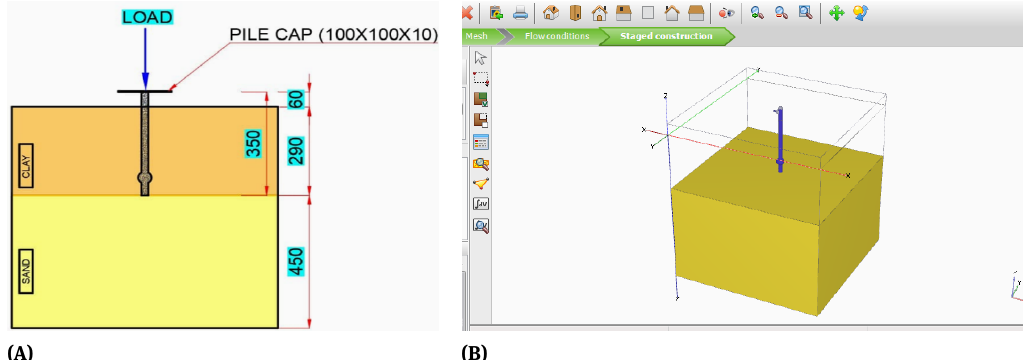
Figure 2: 3-Dimensional model of single bulb pile of the problem geometry under lateral